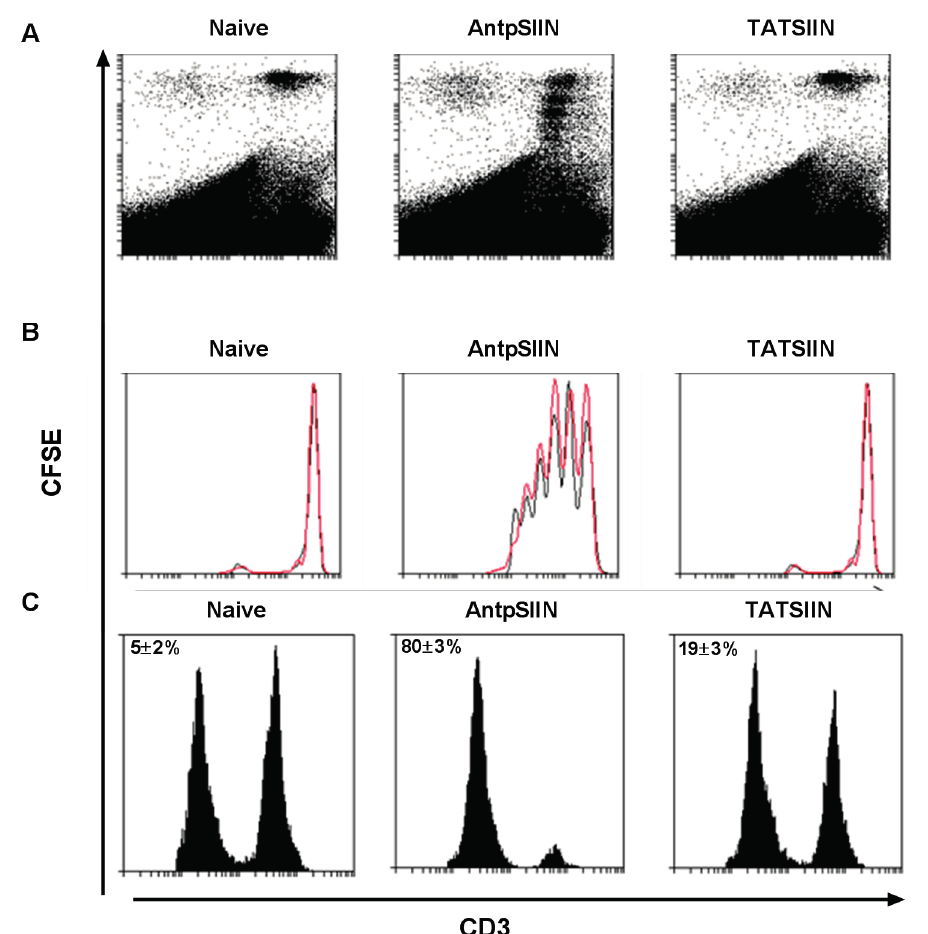
Figure 2. Measurement of in vivo CD3 + T cell proliferation and CTL lysis. C57BL/6 mice were immunised i.d. with PBS, AntpSIIN or TATSIIN and purified CFSE labelled OT-I strain T cells were injected i.v. Splenocytes were subsequently assessed via flow cytometry. CD3 + OT-I T cells that have undergone 0–5 cell divisions are shown as representative dot plots ( A ) and as CFSE profile histograms ( B ); with viable CD3 + OT-I T cells (black line) and CFSE curve fitting generated by the Weasel curve fitting software (red line); ( C ) The percentage of SIINFEKL specific lysis was determined in immunised mice by the in vivo killing assay 8 days later, shown by representative histograms and mean percent killing ± SEM ( n =